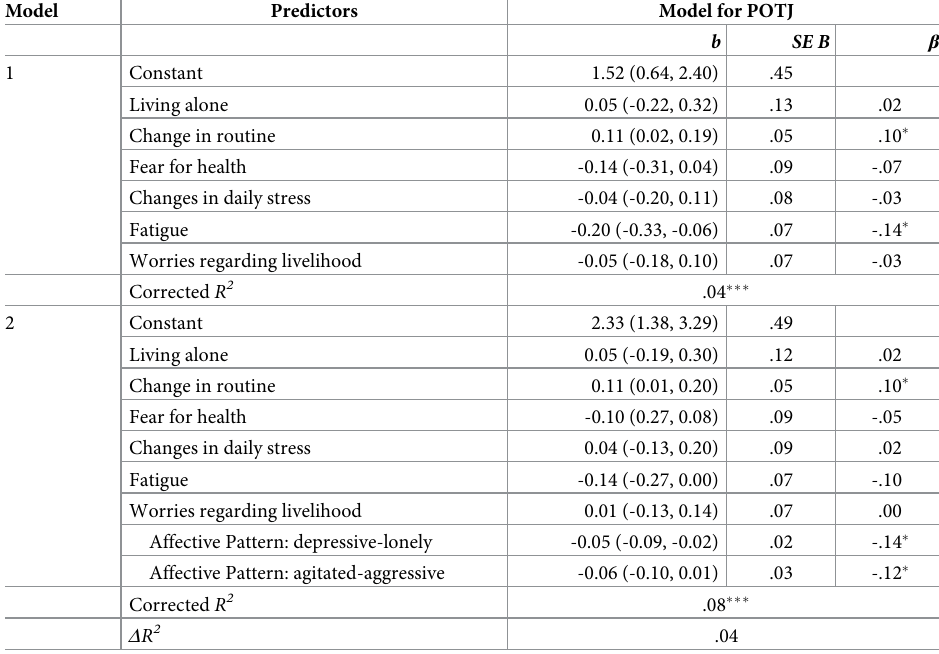
Table 4. Linear model of predictors of DJs for the last 12